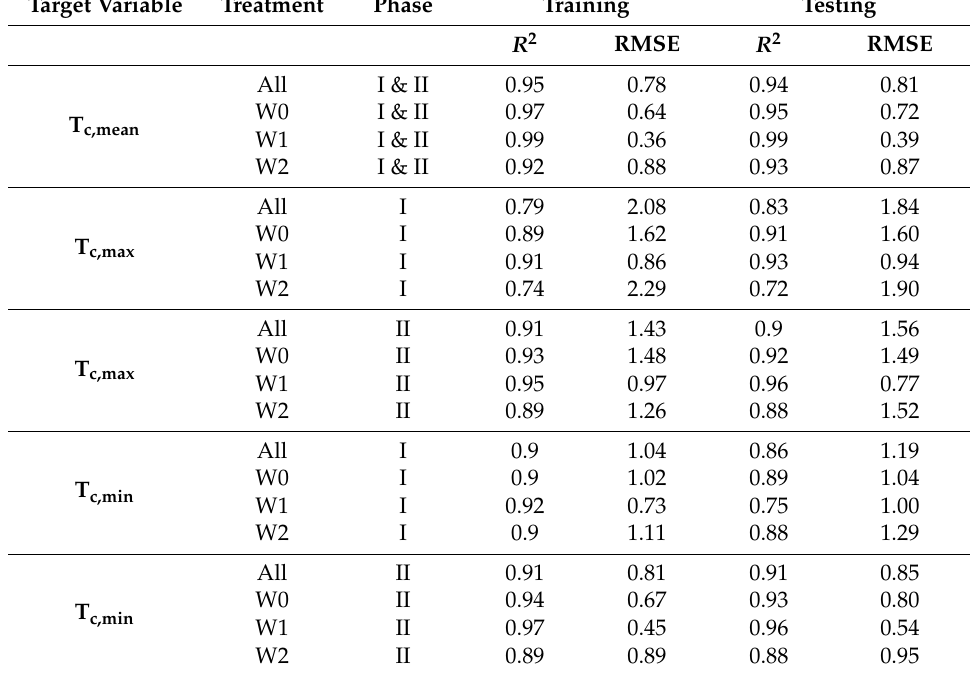
Table 5. Results of the multiple linear regression fit for all data and for the different irrigation treatments (W0–W2, cf . Section 2.1) using phenological subsets (I = pre-heading phase, II = post-heading phase) for modeling T c,mean (mean daily canopy temperature ( ˝ C)), T c,max (maximum daily canopy temperature) and T c,min (minimum daily canopy temperature). R 2 and the root mean squared error (RMSE ( ˝ C)) are given for the training (50% of all observations) and the testing data (50% of all